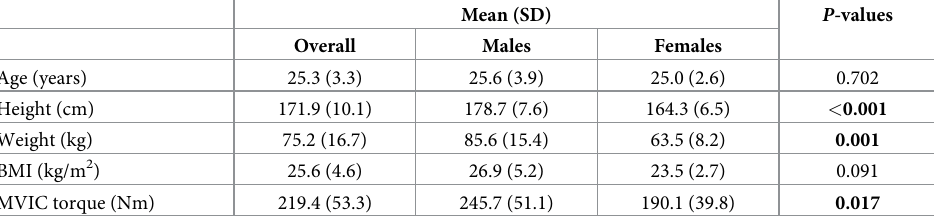
Table 1. Sex differences in demographics and MVIC.